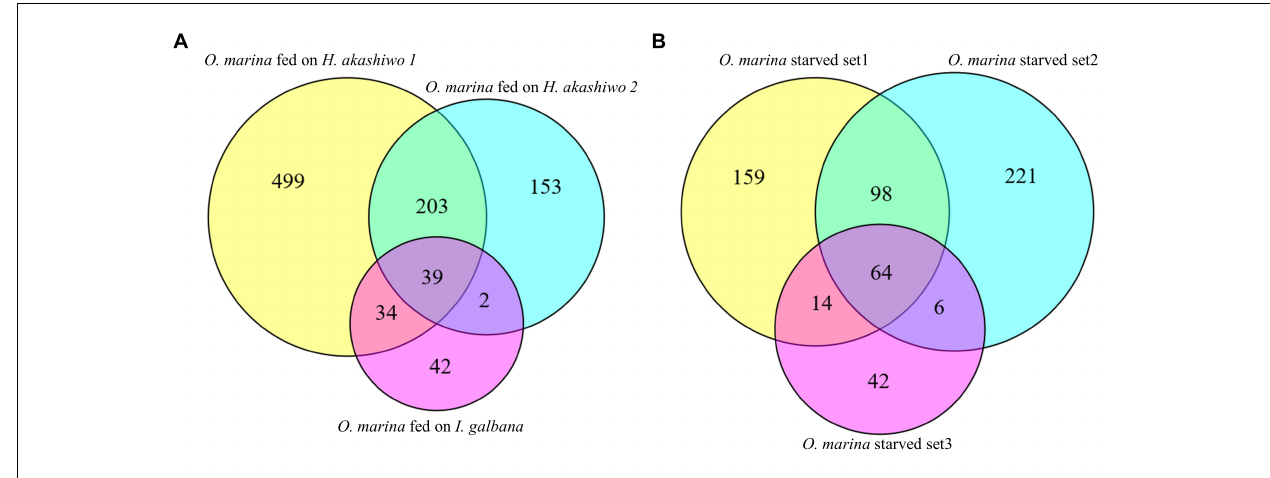
FIGURE 3 | Transcripts found at statistically higher expression (posterior probability ≥ 0.950 and fold change ≥ 2) in (A) O. marina cells fed on three different phytoplankton prey types in comparison to starved O. marina cells and (B) starved O. marina cells in comparison to O. marina cells fed H. akashiwo 1 (starved set 1), H. akashiwo 2 (starved set 2), and I. galbana (starved set 3).